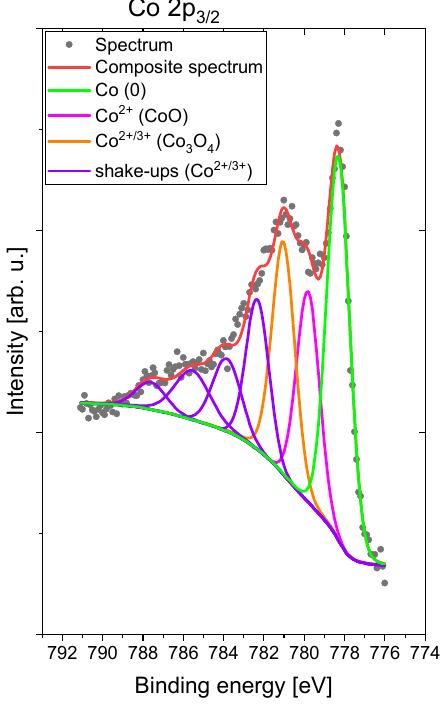
Figure 11. Mapping analysis of obtained coating: ( a ) sample surface image and distribution of: ( b ) Co, ( c ) O and ( d ) Cl.